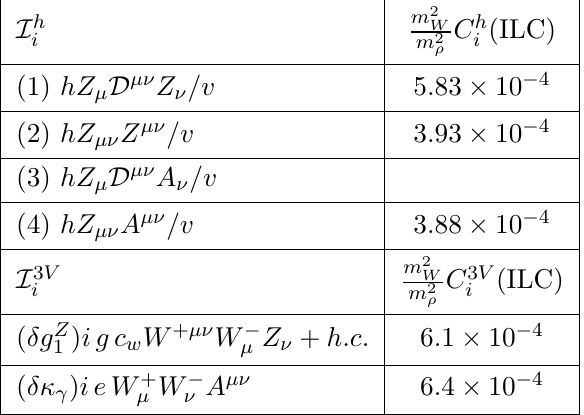
Table 7. Prospective 1 (cid:27) uncertainty at the future lepton colliders, taken from ref. [53]. the (cid:24) obtained from di(cid:11)erent universal relations are inconsistent with each other, then the composite Higgs model is